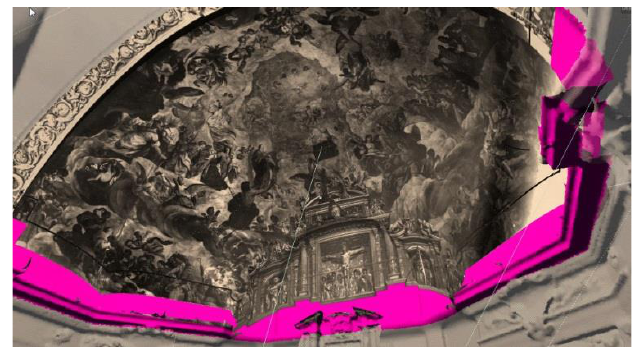
Figure 8. Simulation of the images projected on the vault.